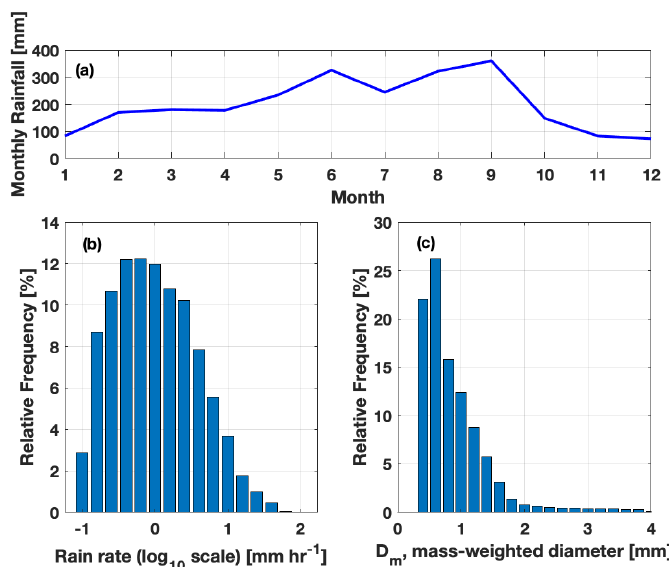
Figure 2. ( a ) The monthly mean rainfall of CWB Taipei weather station in northern Taiwan from 1991 to 2010. The distributions of ( b ) rainfall rate and ( c ) mass-weighted mean diameter (D m , mm) calculated from one-minute DSDs of all sixteen disdrometers for the entire experiment period.